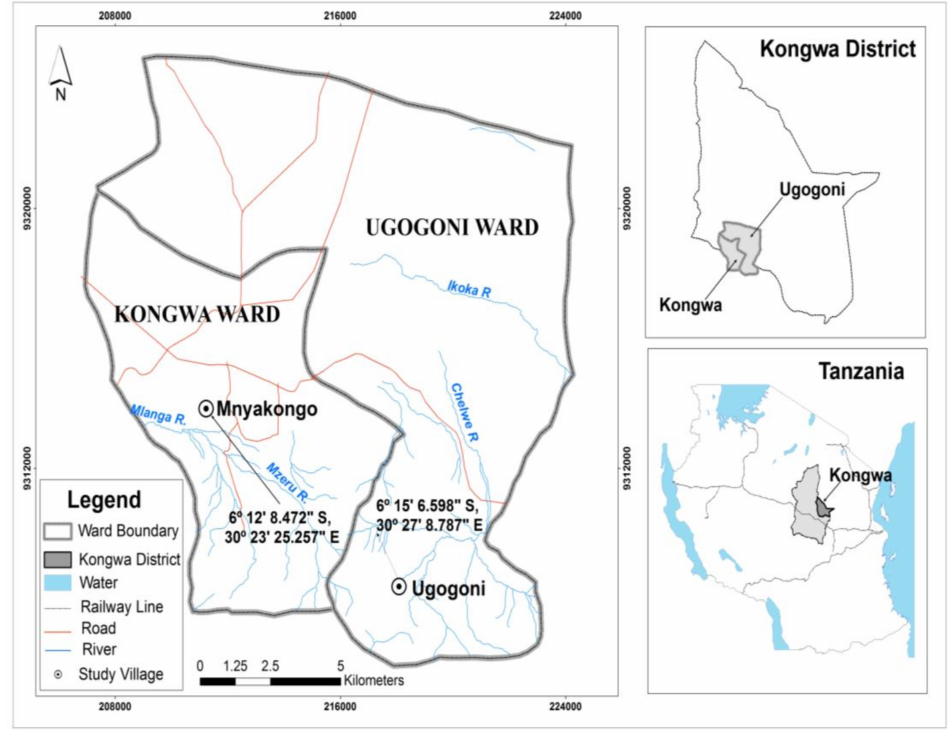
Figure 2. The Study Area. Source: IRA (Institute of Resources Assessment) GIS Lab, UDSM (University of Dar es Salaam):